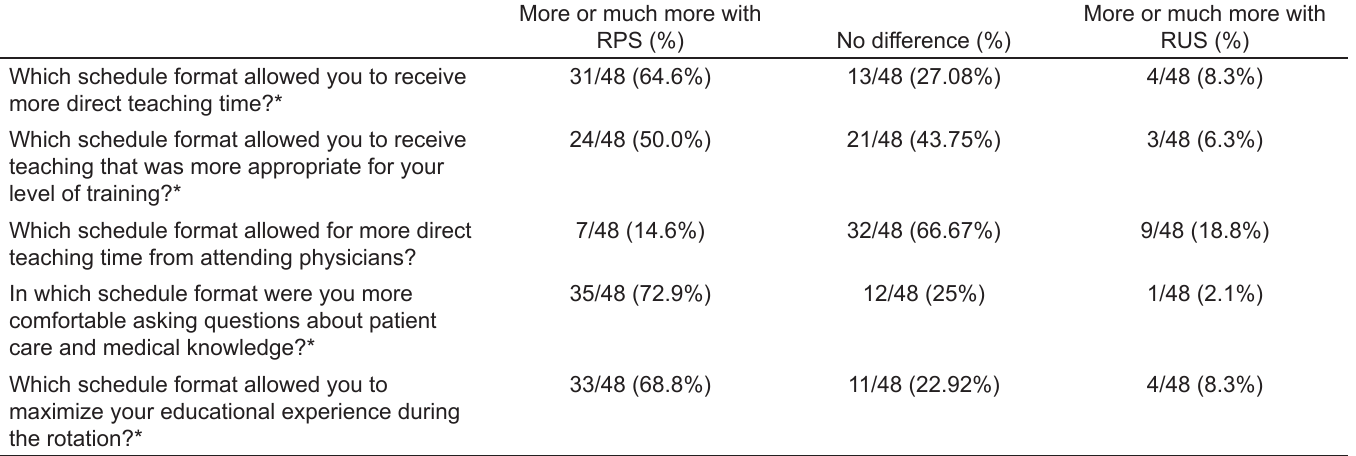
Table 1. Medical student learning experience comparing resident-paired vs unpaired